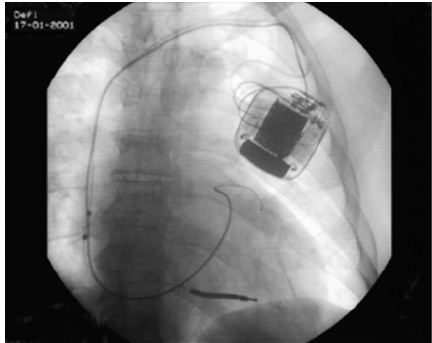
Figure 2: The head of a pacemaker electrode